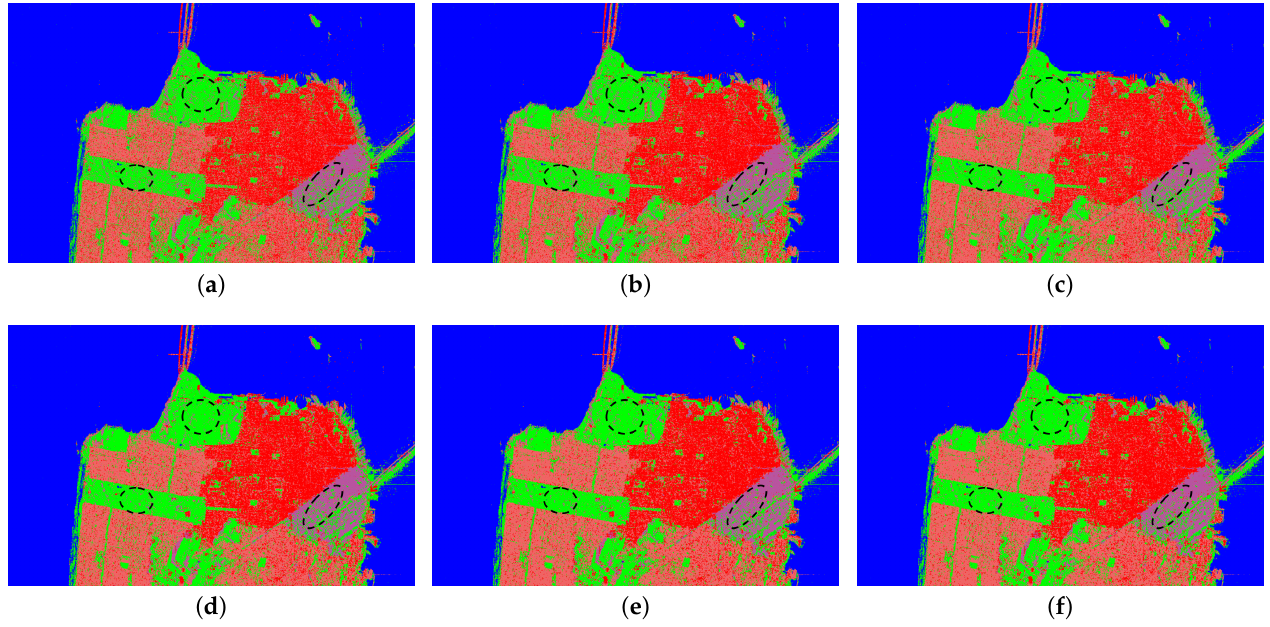
Figure 8. Classification maps of six algorithms on the San Francisco region. ( a ) WMM-MRF. ( b ) RWMM-MRF. ( c ) WMM-MRFs. ( d ) RWMM-MRFs. ( e ) WMM-MRFt. ( f )